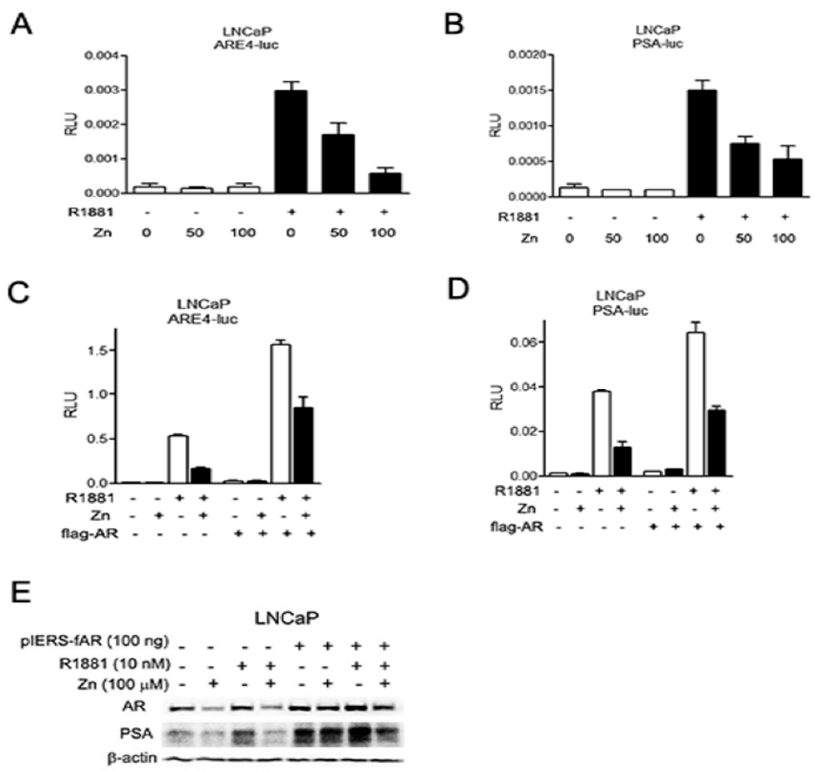
Figure 3. Zinc inhibits androgen-stimulated AR transcriptional activity in AR(+) PCa cells. Cells were treated with either zinc or synthetic androgen, R1881, and luciferase assays were performed 24 h post-transfection. ( A , B ) The effect of zinc on ARE4-luc ( A ) and p61-luc ( B ) was tested in LNCaP cells in the absence and presence of R1881. ( C , D ) Forced expression of AR in the presence of zinc partly restored androgen-stimulated AR activity. ( E ) The effect of exogenous AR on PSA expression was demonstrated by Western blot analysis.